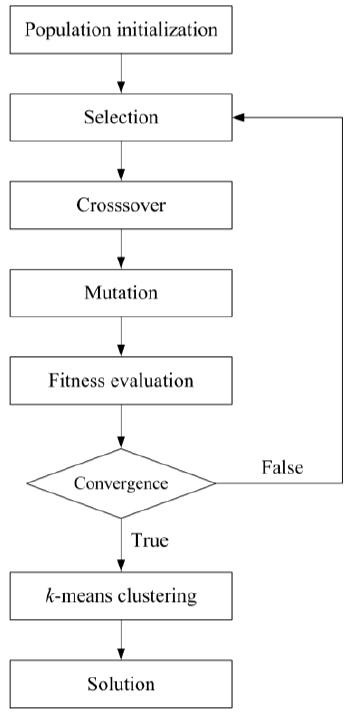
Figure 2. Over flowchart of genetic k -means